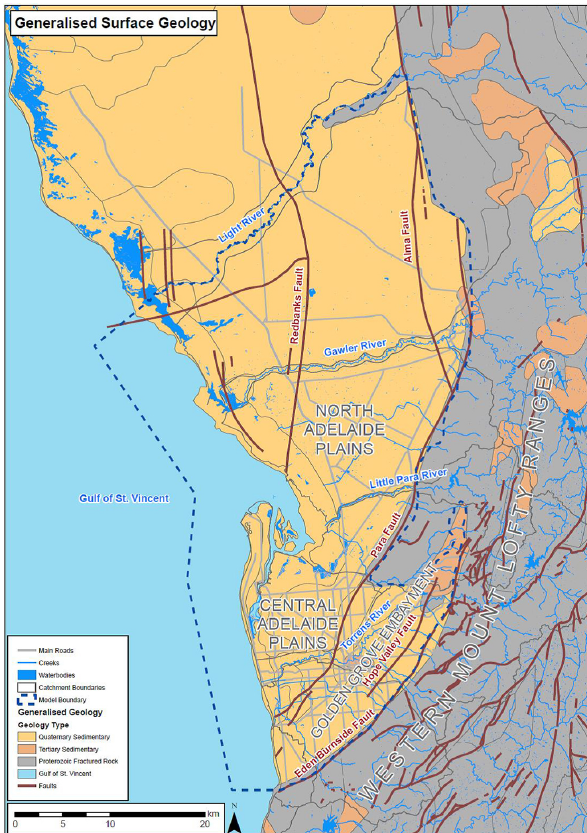
Figure 1. Map indicating the Northern Adelaide Plains region (from Bresciani et al.,